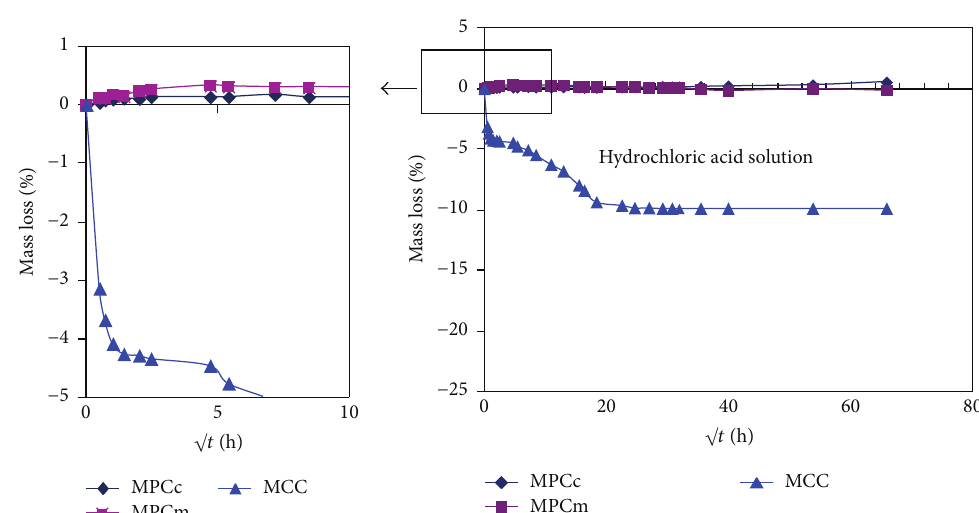
Figure 10: Mass change of microconcretes due to the immersion in hydrochloric